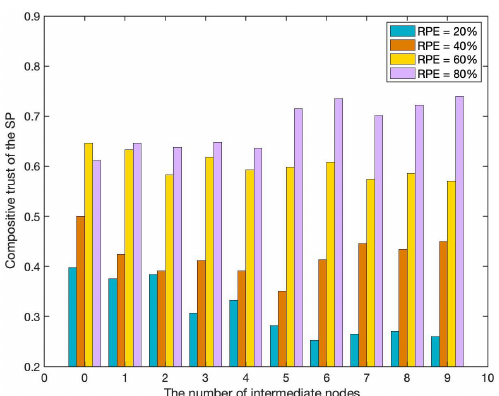
Figure 7. Trust evaluation of the SP with different number of intermediate nodes.